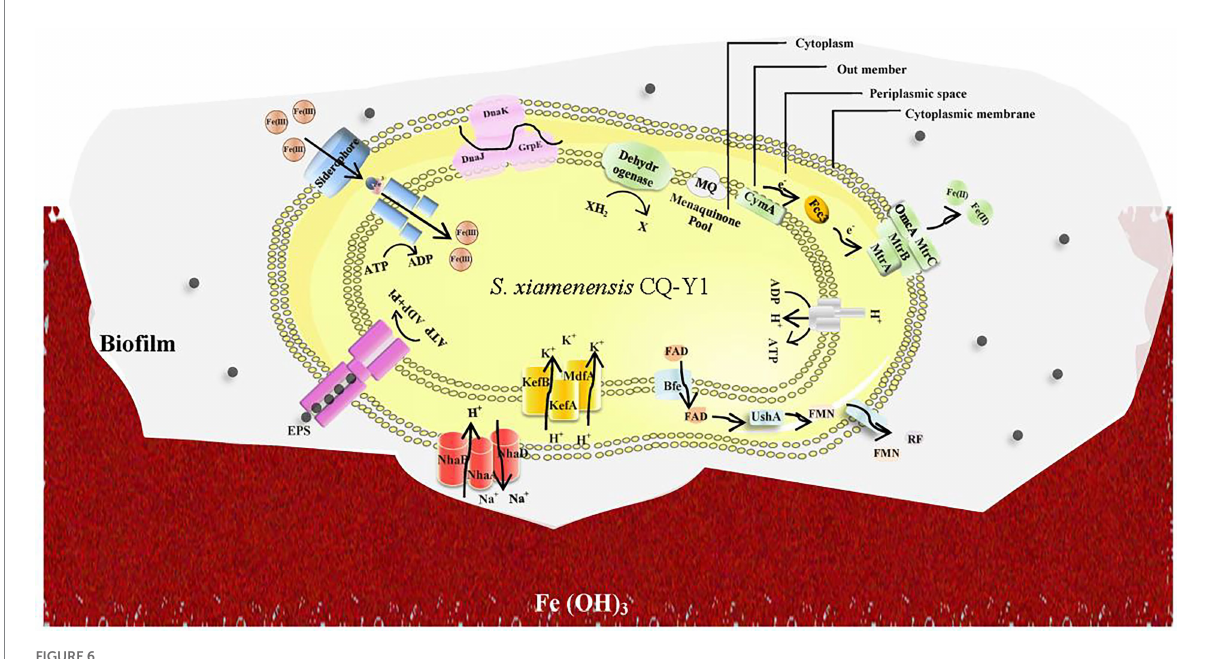
FIGURE 6 A hypothetical Fe(III) reduction mechanism of Shewanella xiamenensis